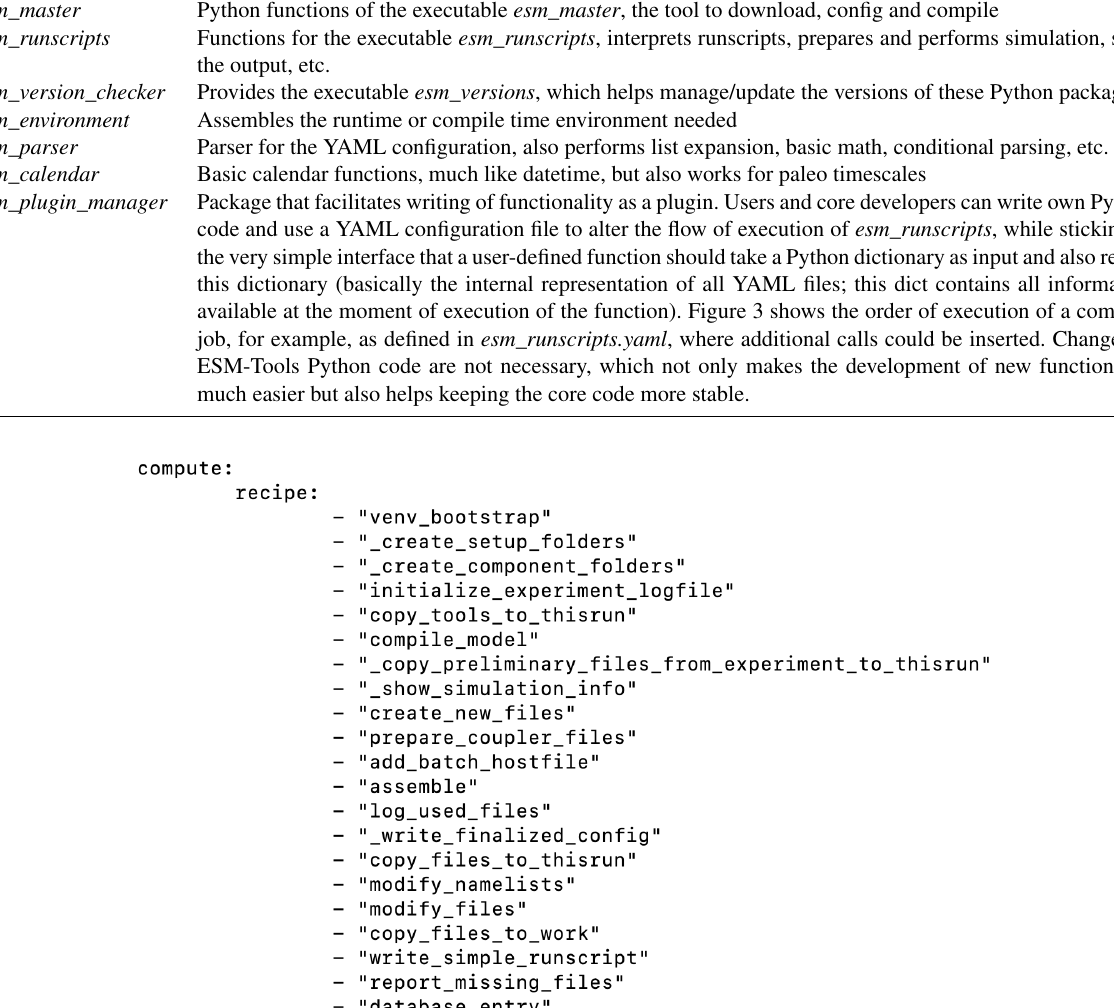
Table 1. ESM-Tools Python packages. Python package